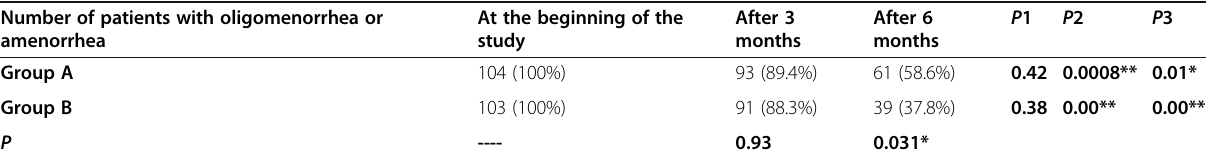
Table 2 Comparison between the two studied groups in number of patients with oligomenorrhea or amenorrhea Number of patients with oligomenorrhea or amenorrhea